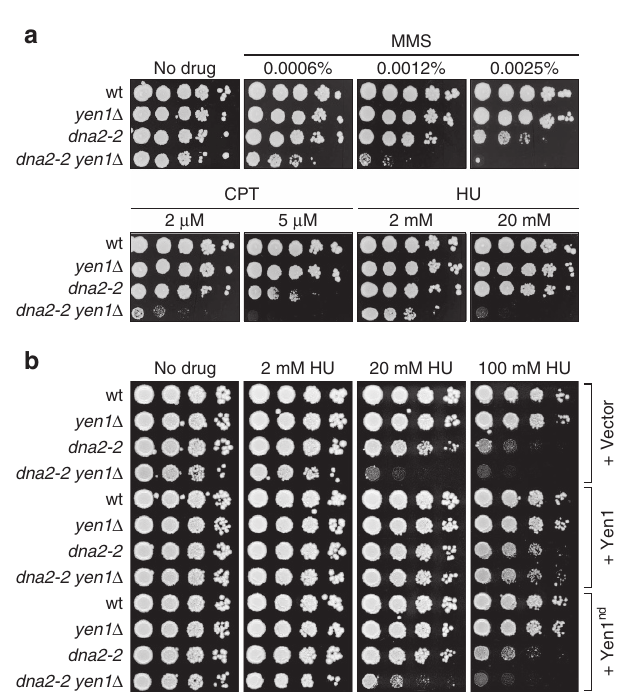
Figure 3 | Dna2 helicase dysfunction and loss of Yen1 nuclease activity synergistically sensitize cells to exogenous replication stress. ( a ) Drop assays to determine the drug-sensitivity of the indicated strains were done by spotting normalized tenfold serial dilutions of exponentially growing cells onto YPAD plates containing the indicated amounts of MMS, CPT or HU. ( b ) Analysis of the effects of Yen1 overexpression. Cells of the indicated strains were transformed with empty vector, or derivatives encoding wild- type or nuclease-deficient (Yen1 nd ) versions of Yen1, and plated on YPAD medium in the presence or absence of suggesting that the functional overlap of Dna2 and Yen1 relates to replication fork stalling. This also suggests that endogenous replication problems are responsible for the growth defects of dna2-2 and dna2-2 yen1 D cells in unperturbed conditions.